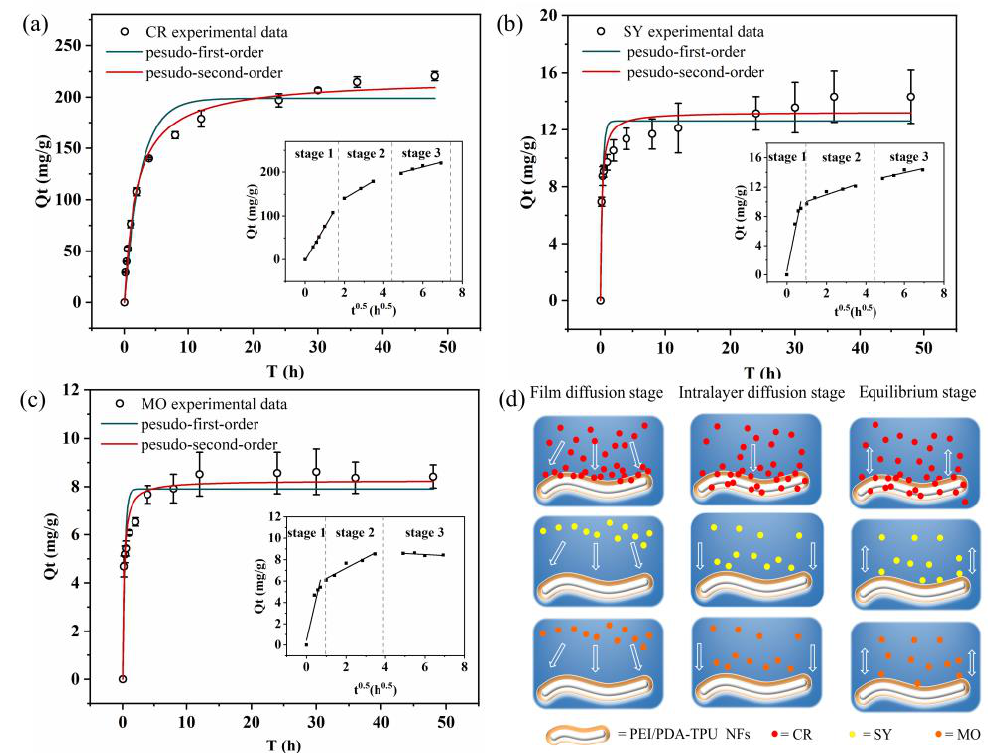
Figure 11. Adsorption kinetics of CR ( a ), SY ( b ) and MO ( c ) fitted with pseudo-first-order and pseudo-second-order models. Inset was intra-particle diffusion model. ( d ) Schematics of the diffusion process of CR, SY and MO onto PDA/PEI-TPU NFMs. Table 2. Kinetic parameters for adsorption of three dyes onto the PDA/PEI-TPU NFMs.